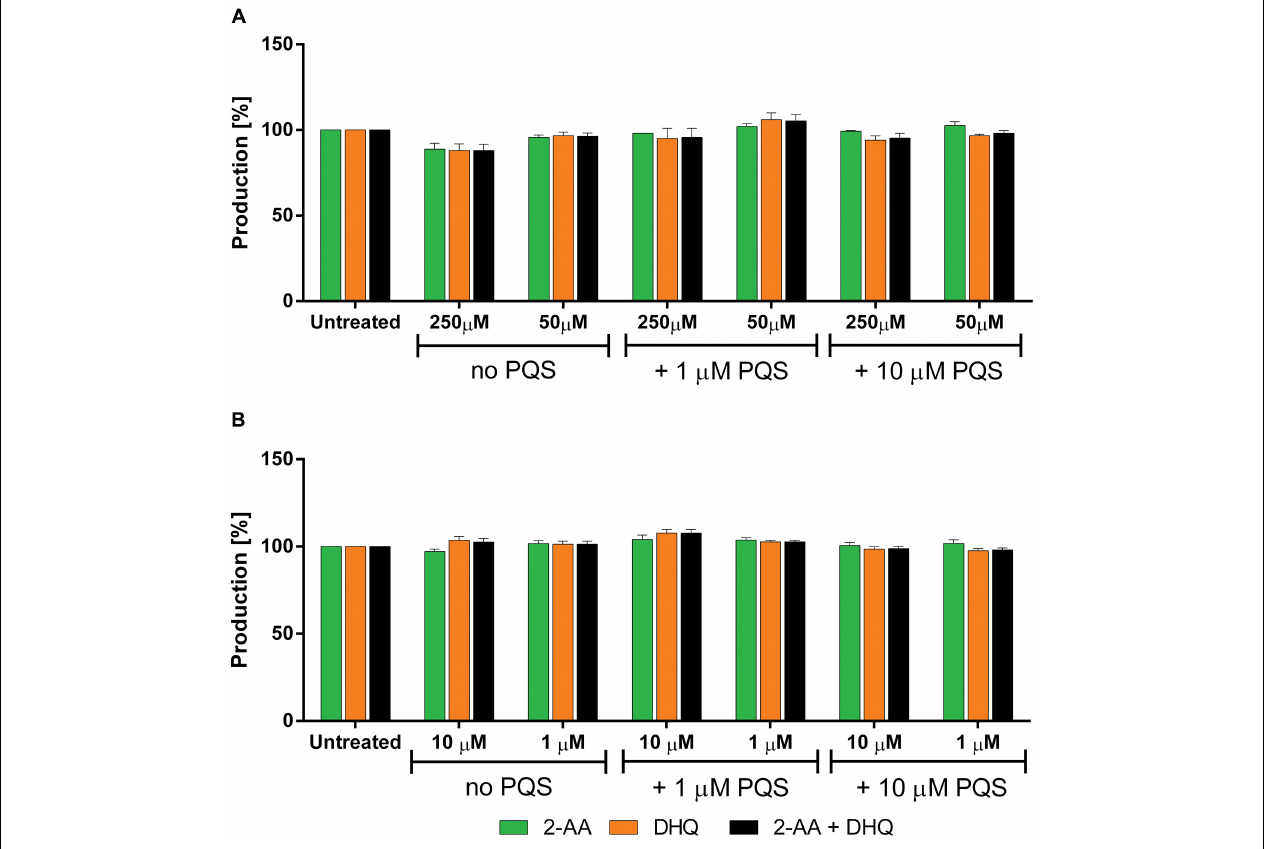
FIGURE 8 | Effects of PqsBC inhibitors on 2-AA and DHQ production in PA14 pqsC mutant. (A) 2 and (B) 3 . 2-AA: green. DHQ: orange. Sum of all anthranilic acid derivatives: black. The error bars indicate Standard Error of the Mean. Statistical analysis performed with one-way ANOVA ( α =